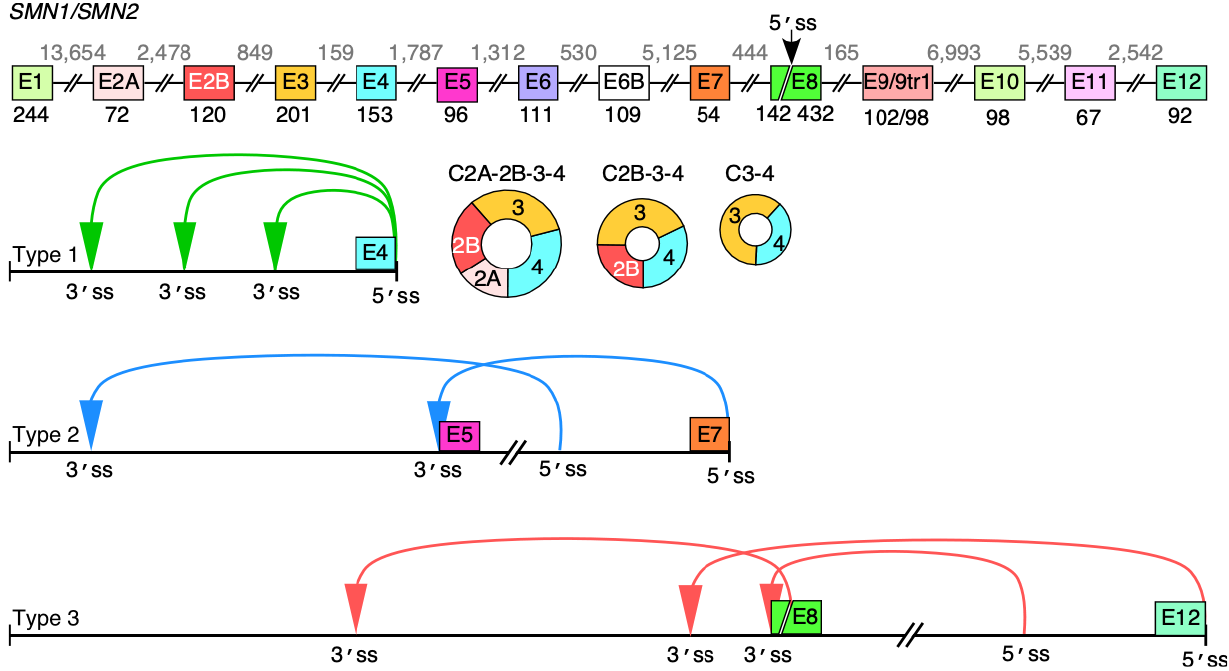
Figure 1. Major backsplicing events in SMN genes. Overview of the SMN genes and circular RNA they produce. Exons are depicted as colored shapes, while introns are shown as lines/broken lines. Sizes of exons and introns are given below exons and above introns, respectively, in the top panel. A novel 5 ′ ss in exon 8 is marked with a black arrow. All identified circRNAs formed by canonical backsplicing events pertaining to the SMN genes are classified into three categories [25]. Type 1 circRNAs are formed by early exons 1 to 4; type 2 circRNAs contain exons 5 to 7 with or without early exons; type 3 circRNAs include the last annotated exon 8 and/or downstream novel exons 9–12. The ranges of exons to form each type of circRNA are marked below the genomic overview. Colored arrows indicate the backsplicing events. The three most abundant type 1 circRNAs are shown as colored circles. The figure was not drawn to scale.